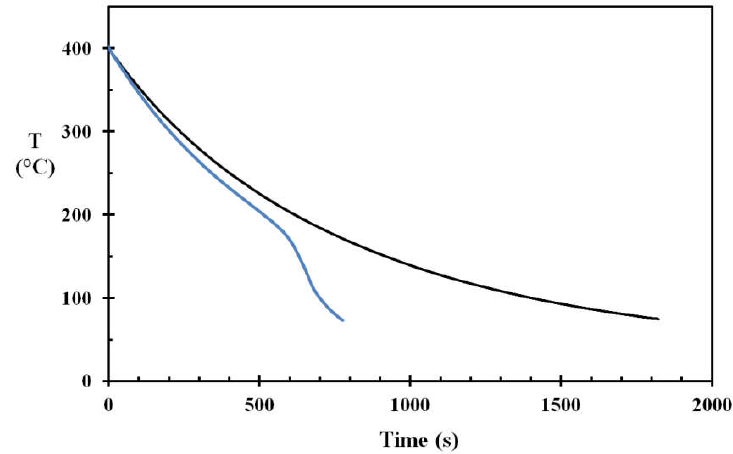
Figure 4. Temperatures of a representative aluminum disc ( blue ) with 2.4-mm diameter droplets and an application rate of 0.02 g/s, with the reference temperatures recorded prior to and after the droplet measurements ( black ).